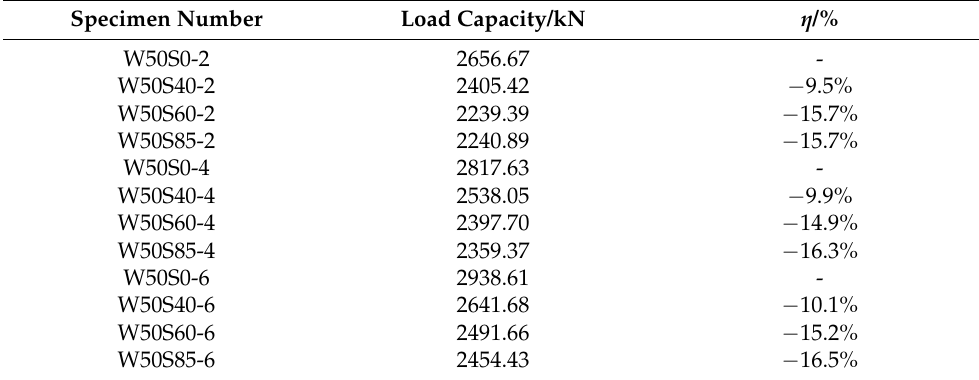
Table 9. Impact of the wrapping interval of the GFRP strip on the load capacity.